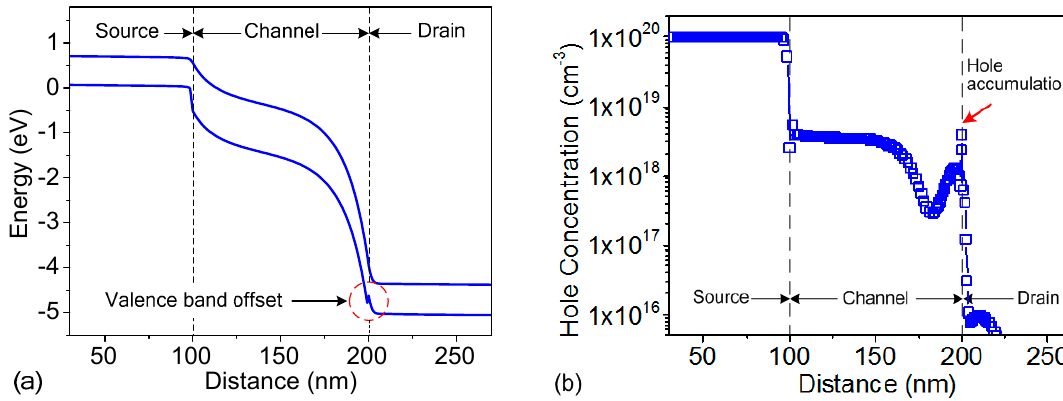
Figure 5. ( a ) Energy bands and ( b ) hole concentration simulated at 90 ns under a TLP current density of 0.5 mA/ μ m, at a distance of 5 nm below the Si/SiO 2 interface.